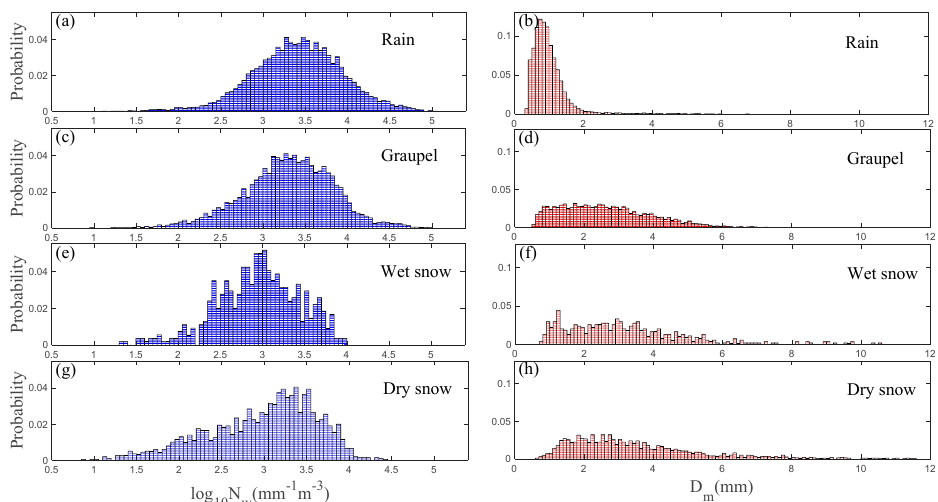
Figure 2. The probability histograms of the normalized intercept parameters log 10 N w (mm − 1 m − 3 )